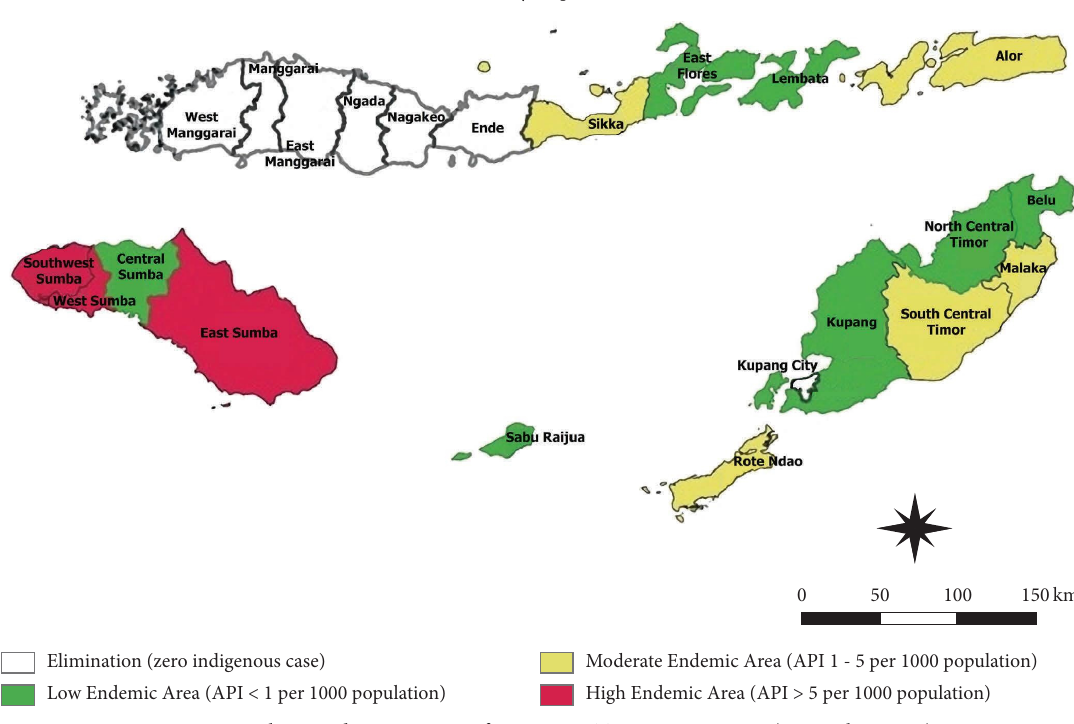
Figure 3: Malaria endemicity map of East Nusa Tenggara province (November